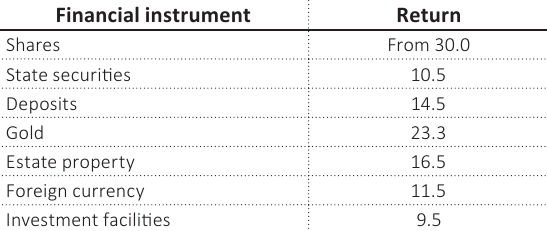
Table 1. Average investment return according to financial instruments in Ukraine in 2019,